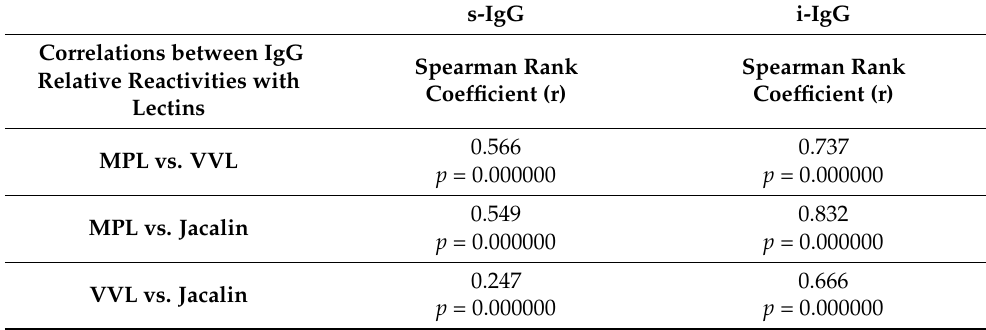
Table 2. Correlations between relative reactivities of s-IgG and i-IgG O-glycans with specific lectins.